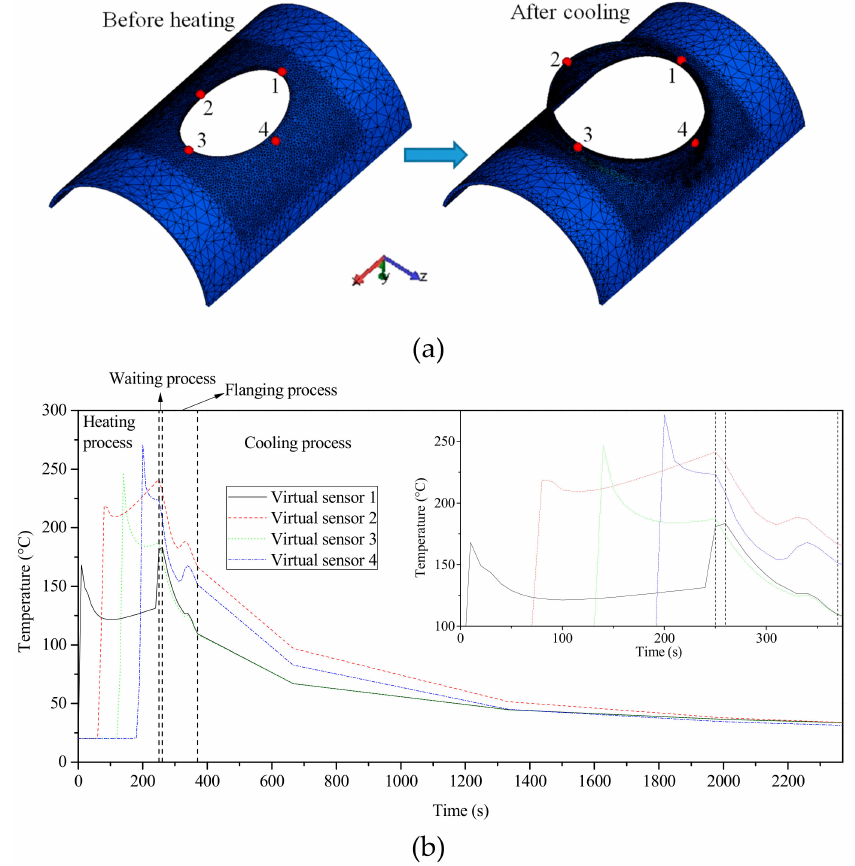
Figure 20. Temperature of virtual sensor during whole process: ( a ) position of virtual sensor; ( b ) temperature–time